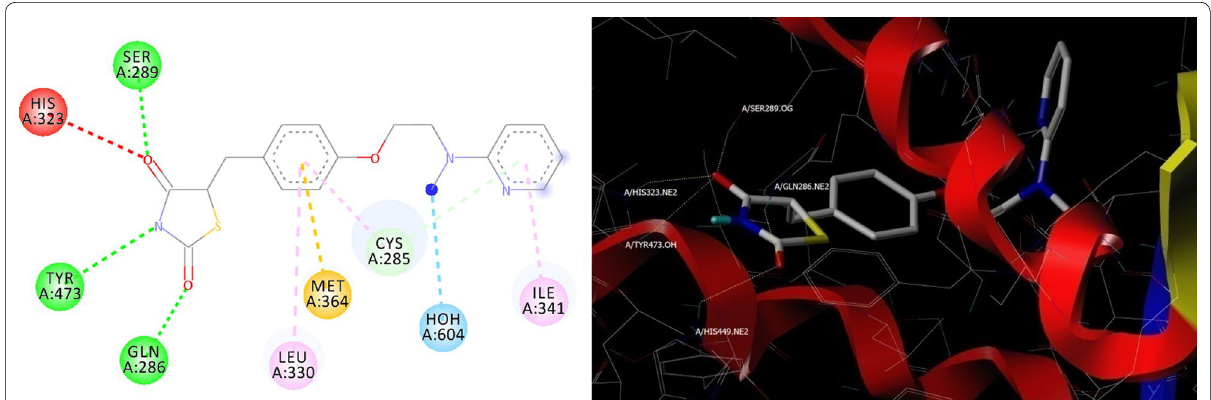
Fig. 4 Binding pose of reference ligand (pioglitazone) present in PPARγ (PDB code: 3CS8) before (2D) and after (3D) Docking studies, His 323, His 449, Tyr 473, Ser 289 and Gln 286 are important binding pocket amino acids to form hydrogen bonds (yellow dots)